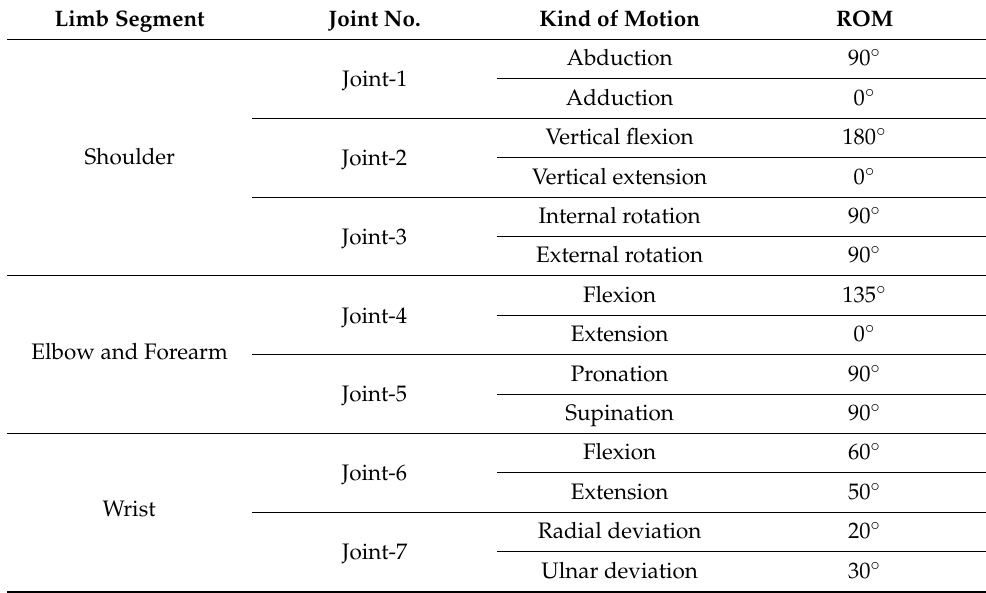
Table 1. Comparison of the ranges of motion of the proposed exoskeleton robot with existing robots. Limb Segment Joint No. Kind of Motion ROM Abduction 90 ◦ Joint-1 Adduction 0 ◦ Vertical flexion 180 ◦ Shoulder Joint-2 Vertical extension 0 ◦ Internal rotation 90 ◦ Joint-3 External rotation 90 ◦ Flexion 135 ◦ Joint-4 Extension 0 ◦ Elbow and Forearm Pronation 90 ◦ Joint-5 Supination 90 ◦ Flexion 60 ◦ Joint-6 Extension 50 ◦ Wrist Radial deviation 20 ◦ Joint-7 Ulnar deviation 30